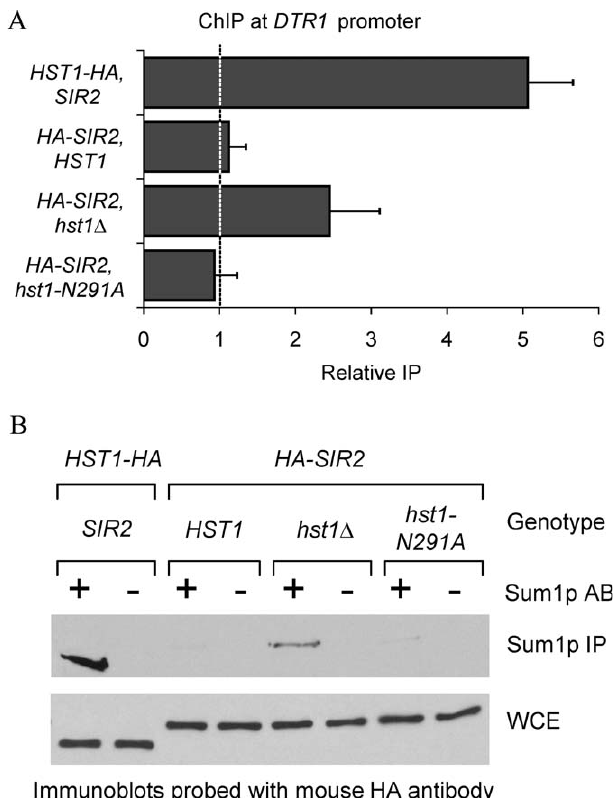
Figure 2. Sir2p Associates with the Sum1 Complex. (A) Association of HA-Sir2p (pRO298) with the DTR1 promoter in wild-type (W3031-a), hst1-N291A (LRY1306), and hst1 D (LRY198) strain backgrounds was assessed by ChIP followed by quantitative PCR. Also shown is the association of Hst1p-HA (LRY558) with the same promoters in a wild-type background.Associationatthe DTR1 (Bprimers)promoterwasnormalized to an internal control, the ATS1 promoter, which is not regulated by Hst1p or Sir2p. The y-axis represents the enrichment of DTR1 relative to ATS1 . A value of one (dashed line) corresponds to no enrichment. (B) The association of HA-Sir2p or Hst1p-HA with Sum1p was assessed by co-precipitation. Sum1p was immunoprecipitated from whole-cell extracts from the same strains used in (A), and the precipitated material was examined by immunoblotting with an a -mouse HA antibody to detect Hst1p-HA or HA-Sir2p.